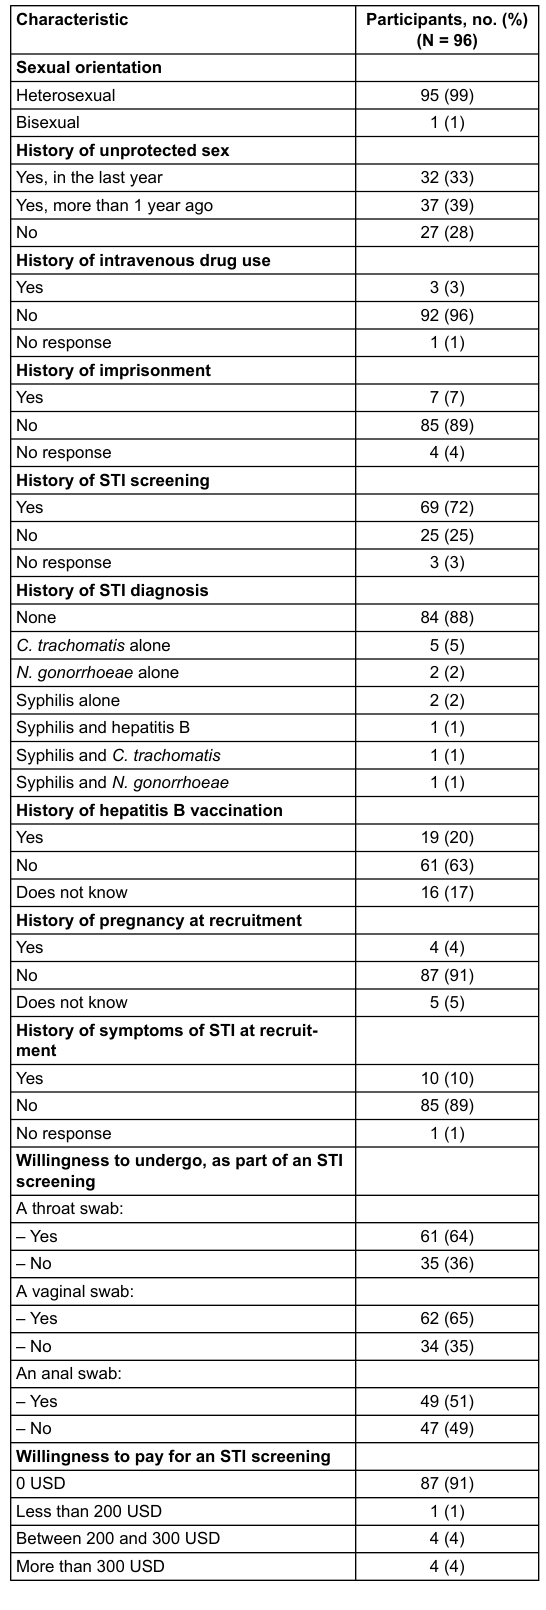
Table 2: Risk factors and basic medical information of the participants and their willingness to undergo a sexually transmitted infection (STI) screening. The study was performed from 1 April 2015 to 31 Decem- ber 2016 in Lausanne, Switzerland.